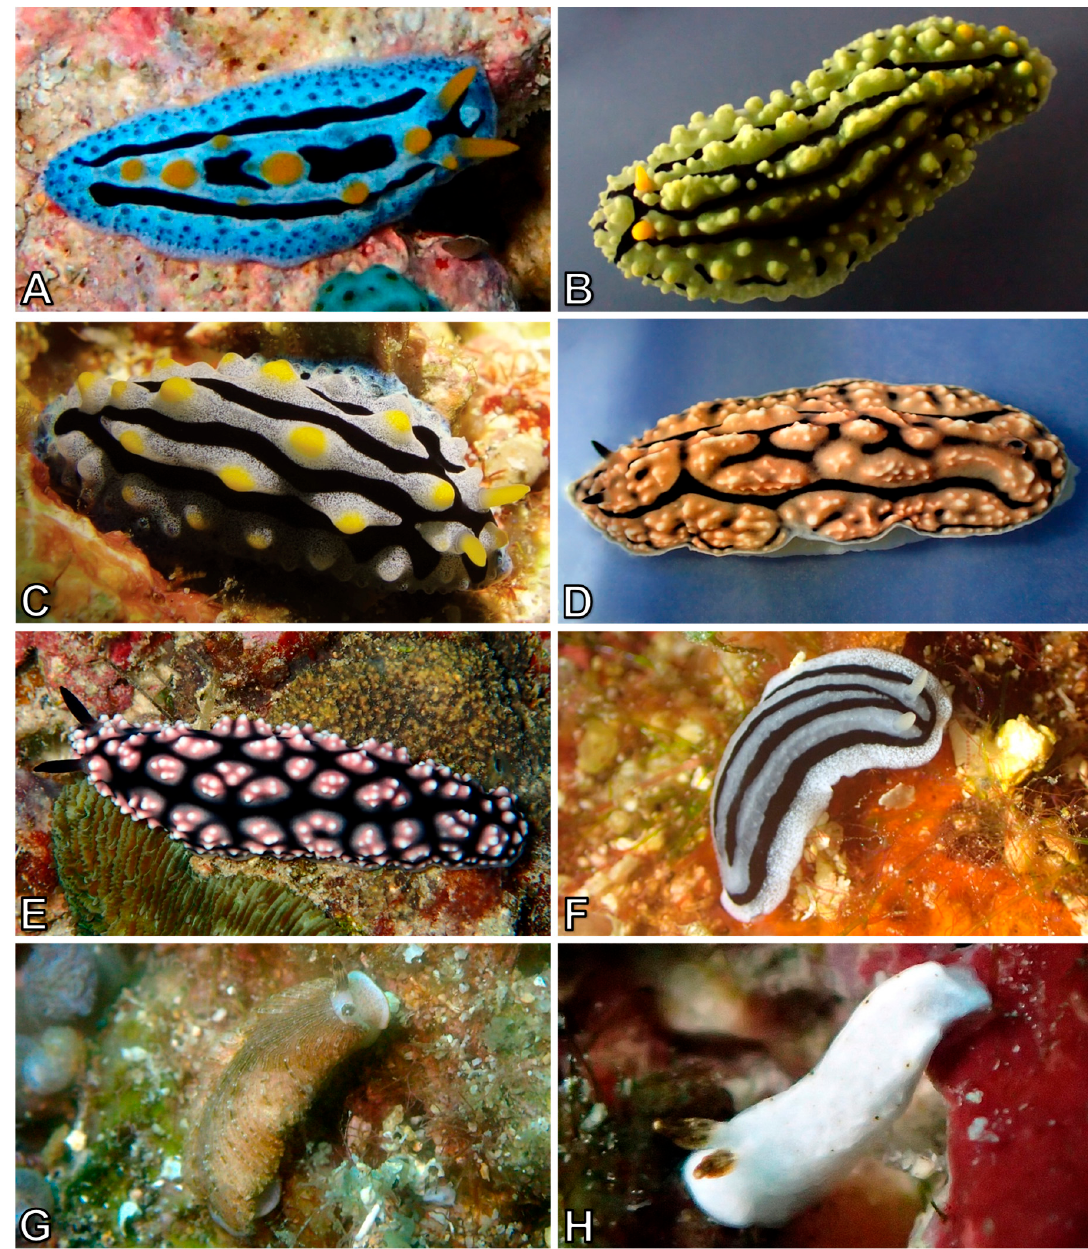
Figure 11. Nudibranchia - Doridina and Nudibranchia - Cladobranchia: ( A ) Phyllidia coelestis ; ( B ) Phyllidia elegans; ( C ) Phyllidia varicosa ; ( D ) Phyllidiella cf. annulata ; ( E ) Phyllidiella pustulosa ; ( F ) Phyllidiopsis xishaensis ; ( G ) Dermatobranchus diagonalis ; ( H ) Dermatobranchus cf. kokonas . 3.1.6. Nudibranchia, Cladobranchia (36 species in 20 genera belonging to 11 families, Figures 12A–16B)